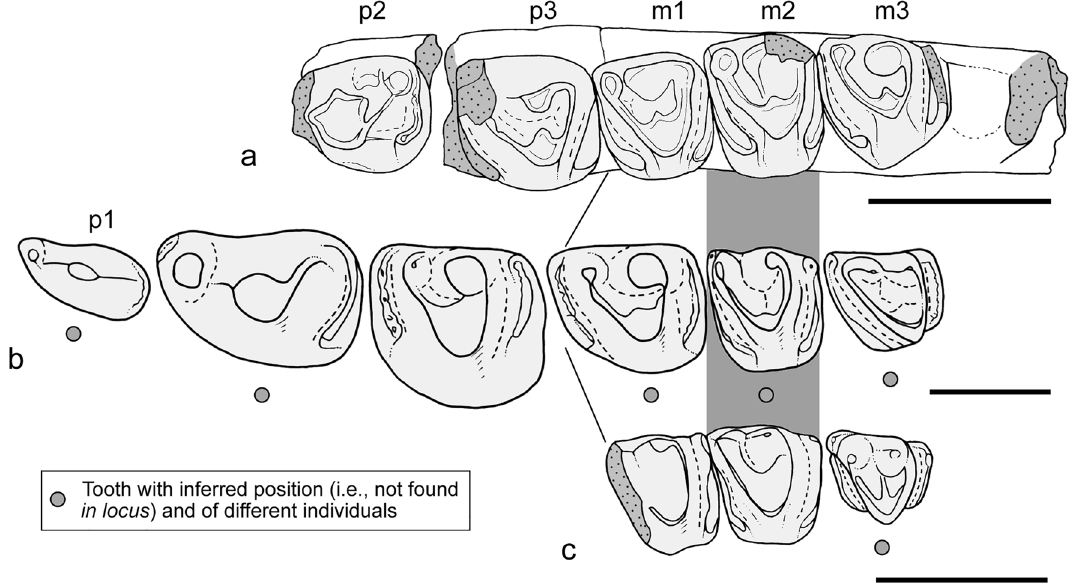
Figure 9. Comparison of lower postcanine teeth among selected mesungulatid mammals. ( a ) Orretherium tzen gen. et sp. nov. (CPAP-5007, holotype). ( b ) Coloniatherium cilinskii , premolar-molar sequence reconstructed upon different individuals. ( c ) Mesungulatum houssayi , molar sequence based on two specimens. Drawings made by A.G.M.; ( b , c ) based on Harper et al. 16 and Rougier et al. 15 . They are scaled by the mesiodistal length of m2. Scale bar: 5